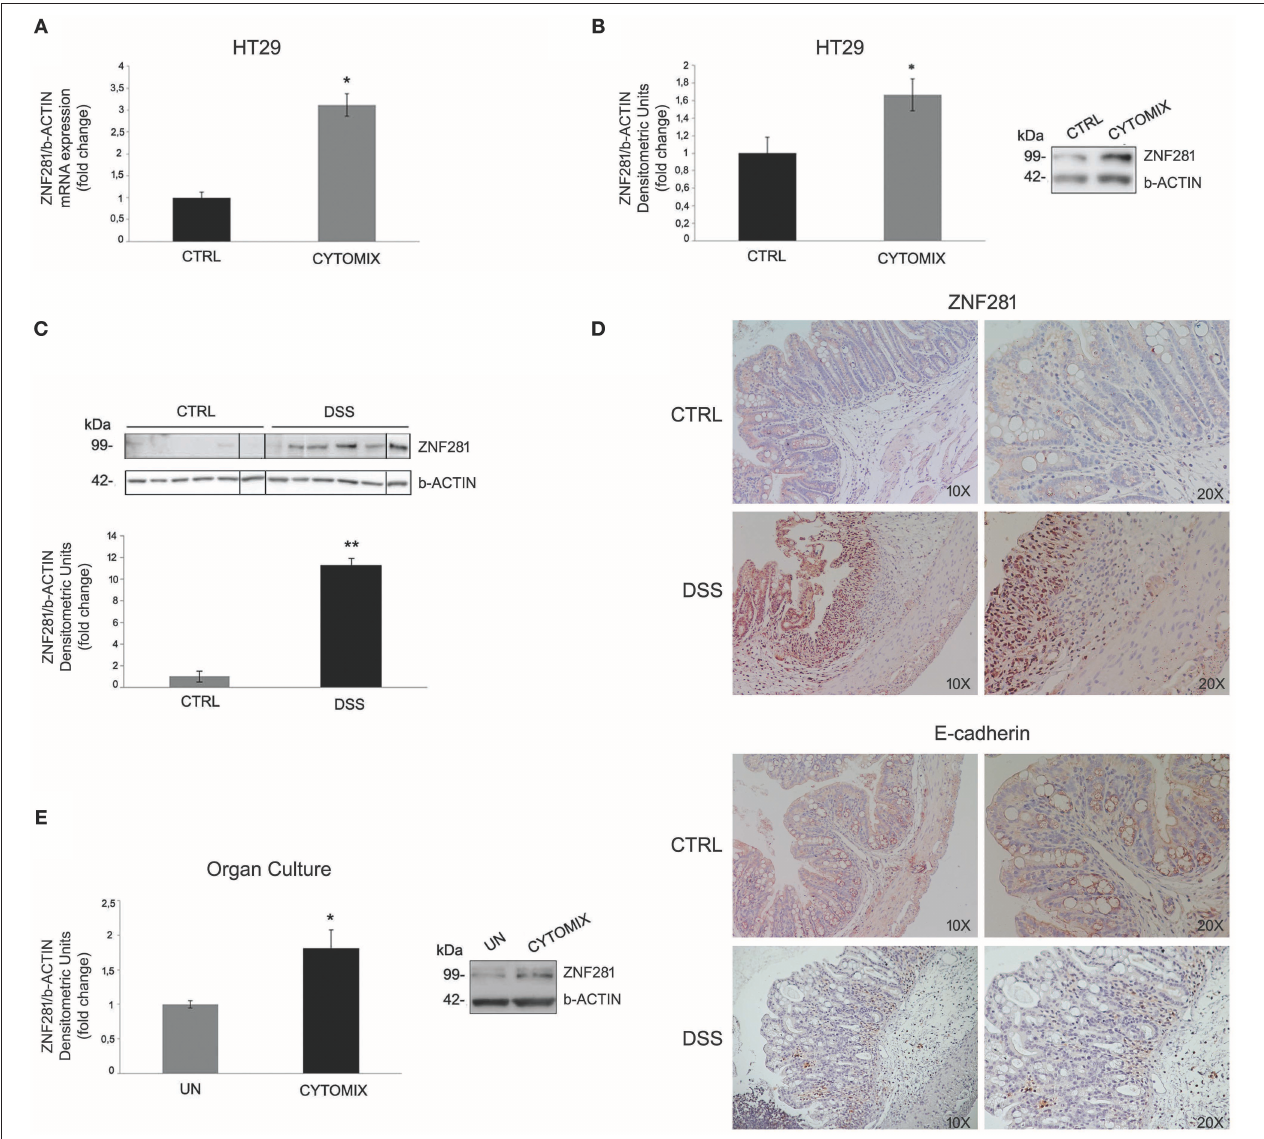
FIGURE 1 | ZNF281 mRNA (A) and protein (B) expression levels are increased in HT29 cells exposed to cytomix as compared to control cells (CTRL); western blot (C) and immunohistochemistry (D) show that ZNF281 protein expression is significantly upregulated in the colonic mucosa of DSS-treated mice ( N = 6) as compared to control (CTRL) mice ( N = 6) (different gels were indicated); (E) ZNF281 protein expression is significantly increased in colonic mucosal tissues taken from healthy areas of 3CD patients exposed to cytomix and cultured for 24h, as compared to uninflamed (UN) colonic mucosal samples. Densitometric analysis is showed. Data represent the target gene expression normalized to the reference gene. Data are presented as mean ± S.D. of 3 in vitro and ex vivo independent experiments, and 6 animals for each group. CTRL, controls; Cytomix (TNFalpha + IFNgamma); DSS, dextran sodium sulfate; UN, uninflamed. Mann–Whitney t -test. * P < 0.05; ** P < 0.01.